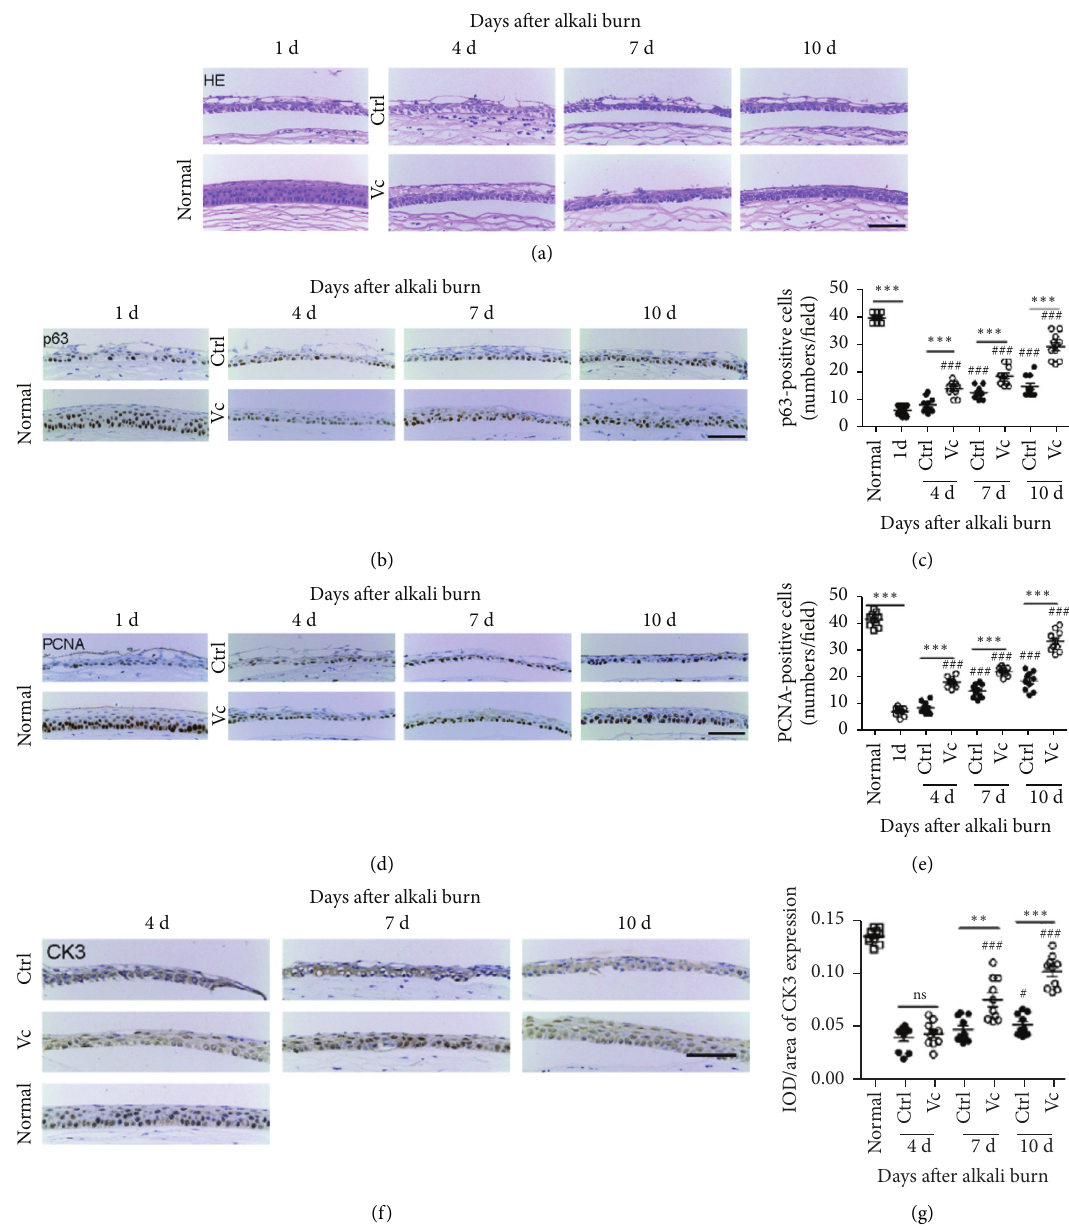
Figure 3: Vitamin C promotes the stemness of corneal epithelial stem cells and increases the CK3 expression in vivo . (a) Representative images of hematoxylin and eosin staining of injured corneas. (b) Immunohistochemical analyses of p63 expression. (c) The number of p63- positive cells in both groups. (d) Immunohistochemical analyses of proliferating cell nuclear antigen (PCNA) expression. (e) The number of PCNA-positive cells in both groups. (f) Immunohistochemical analyses of CK3 expression. (g) The IOD/area of CK3 in the cornea. IOD refers to the integral optical density. Abbreviations: Ctrl, control group (sterile water group); Vc, vitamin C group; ns, no significant difference between the indicated groups. ∗ means the comparison of Vc group and control group. ## and ### means the comparison with day 1. ## in G means the comparison with the Vc group on day 4. ∗ p < 0 . 05, ∗∗ p < 0 . 01, ∗∗∗ p < 0 . 001, ## p < 0 . 01, and ### p < 0 . 001. Scale bar � 50 μ